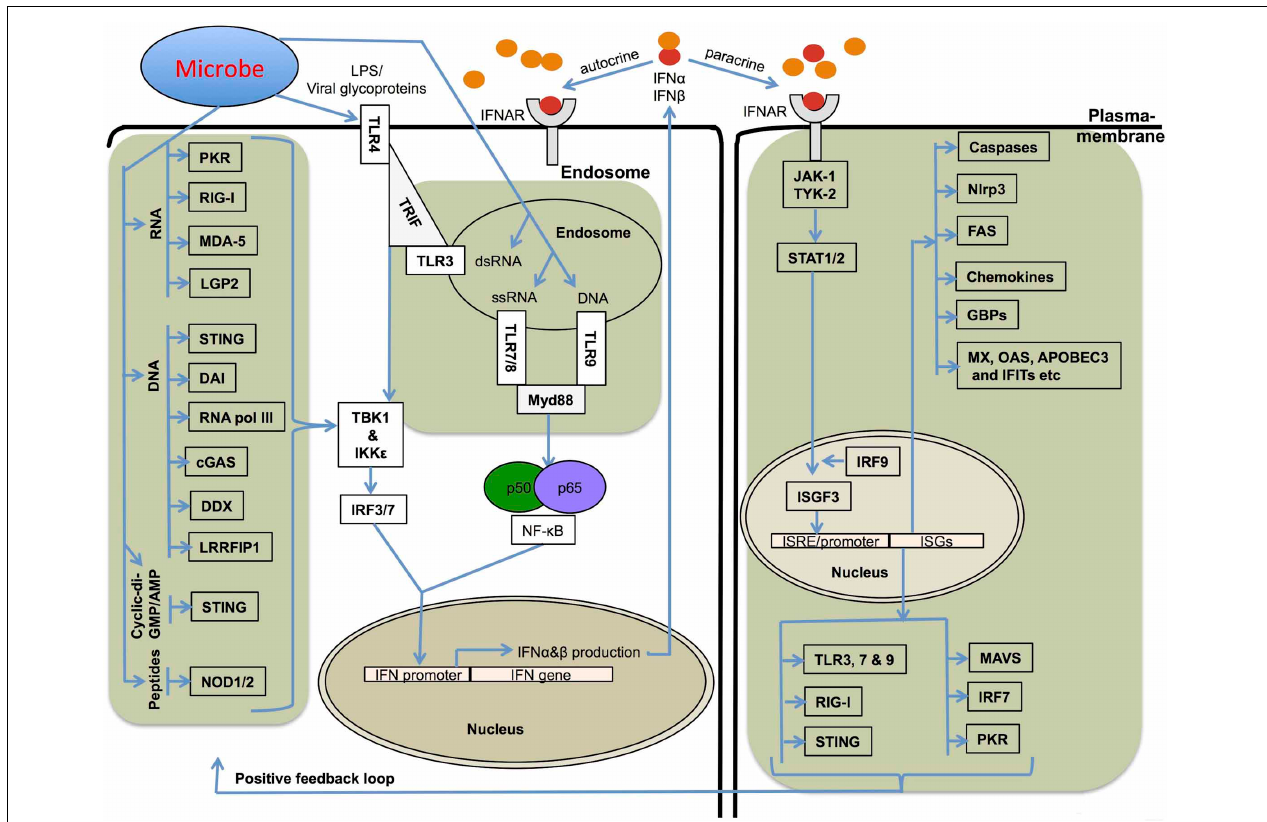
FIGURE 1 | Mechanisms involved in type I IFN production and its receptor signaling. Several different stimuli including pathogen derived LPS, glycoproteins, RNA and DNA can induce type I IFNs (IFN α and IFN β ) via upstream pattern recognition receptors. TLRs sense the endosomally located PAMPs (pathogen associated molecular patterns) and DAMPs (damage associated molecular patterns) and recruit TRIF (TRL3 and TLR4) or Myd88 (TLR4, 7, 8, and 9), which further transfer the signals downstream to IRF3 and IRF7. RLRs, NLRs,DAI,STING, andrelatedreceptors sensenucleic acidsinthe cytoplasm.TheRNAsensors,RIG-I,MDA-5,andLGP2,andDNAsensorSTING